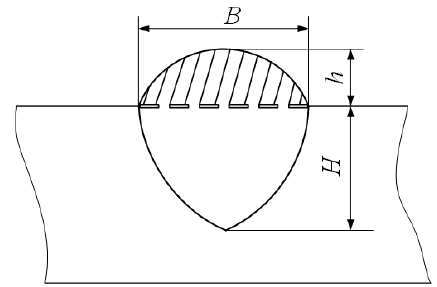
Figure 3. Three geometry characteristic parameters of the weld bead.